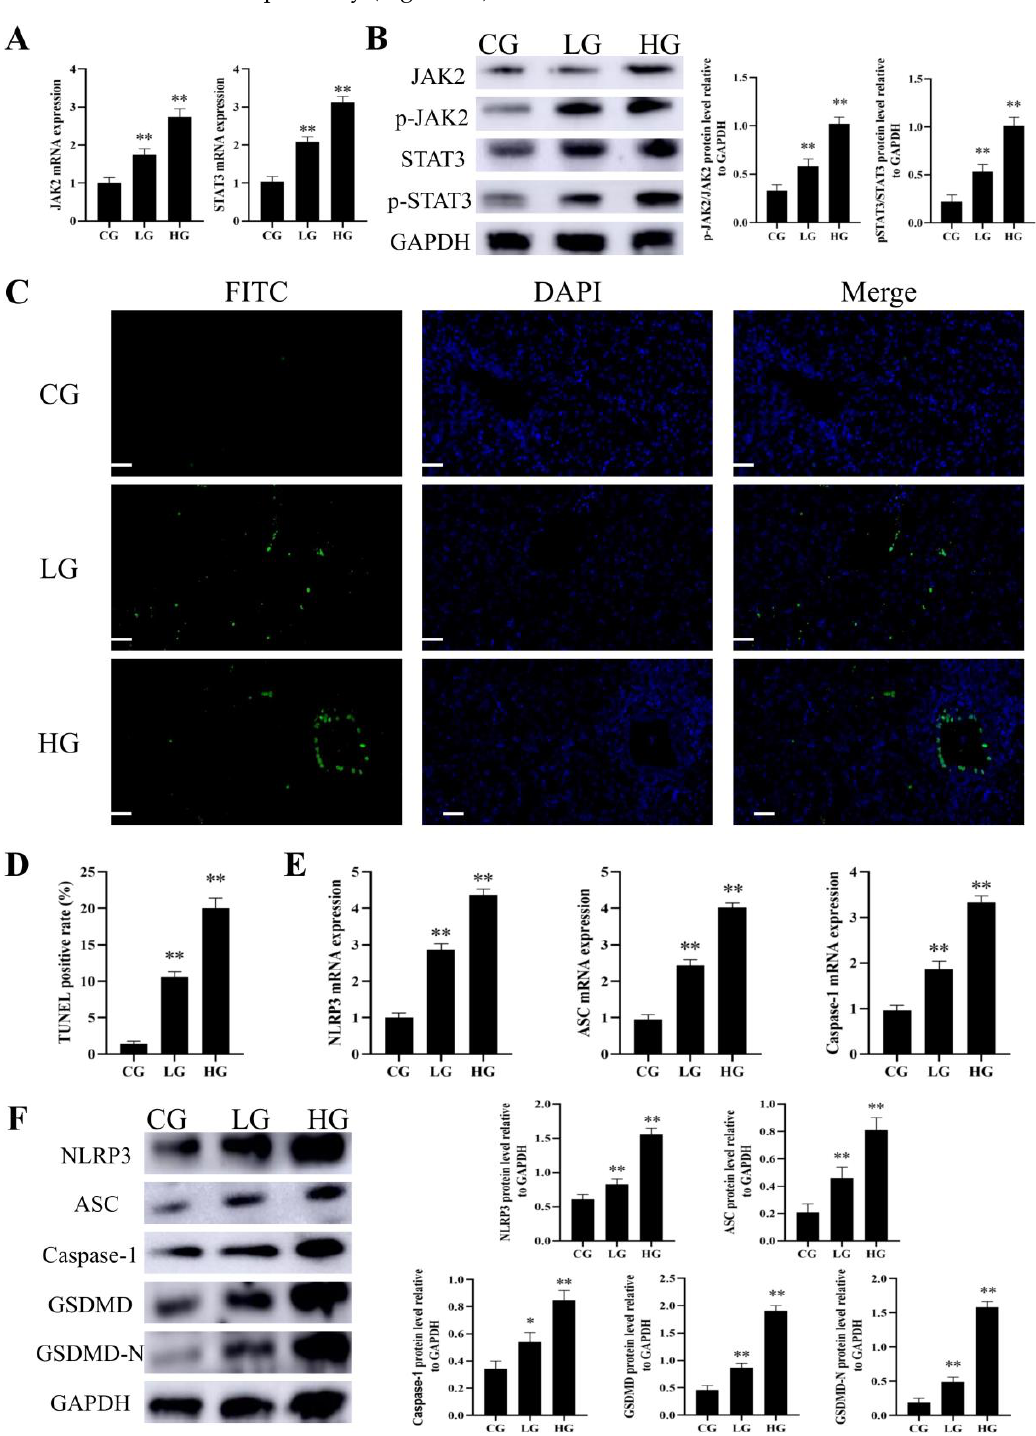
Figure 3. AFB 1 exposure activated JAK2/NLRP3-mediated pyroptosis in duck livers. ( A ) mRNA expressions of JAK2 and STAT3 ( n = 6). ( B ) Western blot of the JAK2, p-JAK2, STAT3, and p-STAT3 protein ( n = 3). ( C ) Representative images of liver TUNEL staining. Scale bar: 50 μm. ( D ) TUNEL analysis of livers ( n = 3). ( E ) mRNA expressions of IL- 1β and IL-18 ( n = 6). ( F ) Western blot analysis of the NLRP3, ASC, Caspase-1, GSDMD, and GSDMD-N protein levels ( n = 3). * p < 0.05 and ** p < 0.01 vs. the CG.